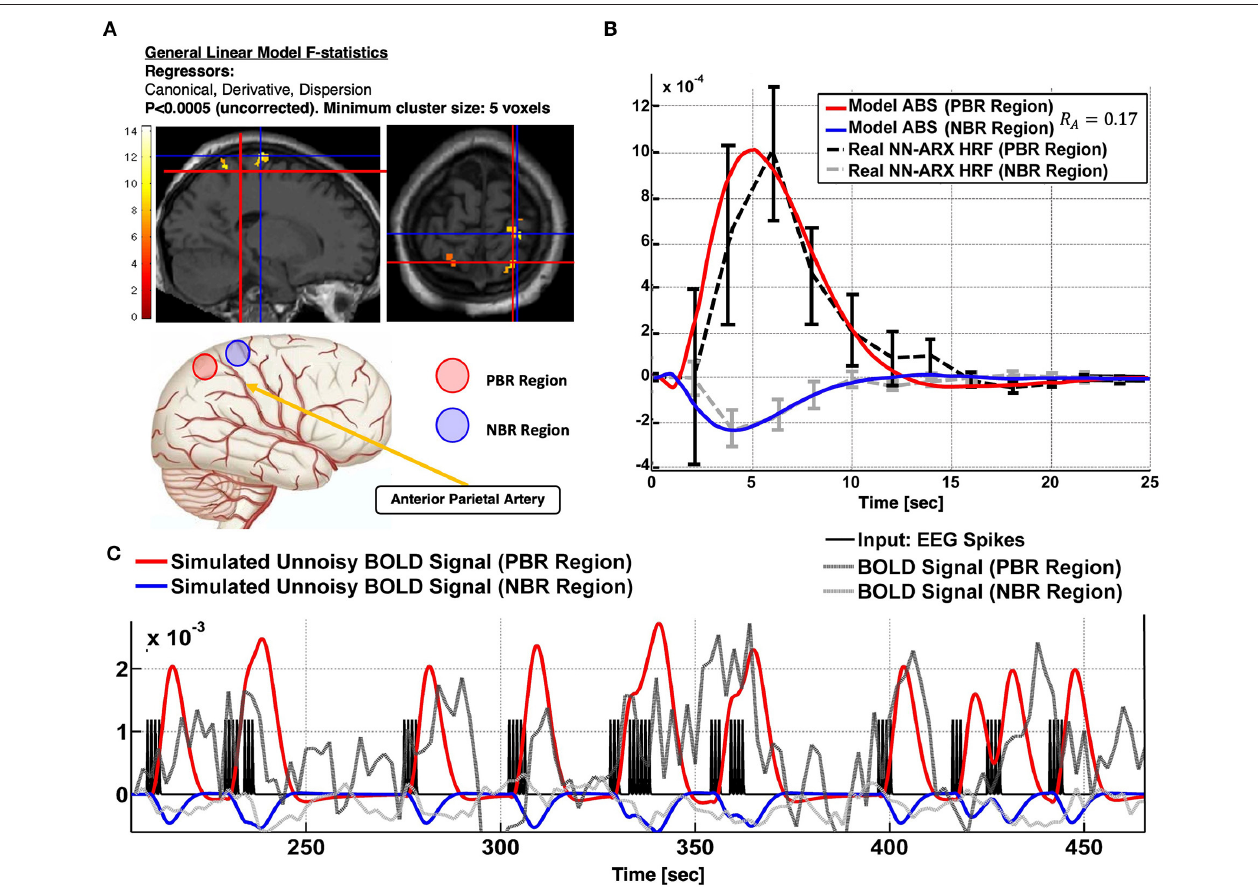
FIGURE 4 | Patient #1 shows an irritative zone with ABS-type HRF. (A) Slices showing the thresholded F-statistics map built from the estimated coefficients of the GLM overlaid on the T1-weighted image. The blue crosshair locates the center of the NBR region in the Right Post-central Gyrus; whereas the red crosshair locates the center of the PBR region in the Right Superior Parietal Lobule (SPL). The cartoon at the bottom illustrates the ABS mechanism-the regions share the final segment of the Anterior Parietal Artery. (B) The dark gray curve shows the estimated NN-ARx PBR-HRF and its confidence interval, estimated from the real data, and averaged across the voxels within a 10 mm-radius sphere with origin in red crosshair in (A) . The light gray curve shows the estimated NN-ARx NBR-HRF and its confidence interval, estimated from the real data, and averaged across the voxels within a 10 mm-radius sphere with origin in the blue crosshair in (A) . The light red and blue curves show the unnoisy simulated PBR-HRF, NBR-HRF of the fitted ABS model with the estimated values R_A = 0.17. (C) Temporal behavior of the ABS simulated BOLD in the PBR and NBR regions (with the above-mentioned estimated parameters), the time series of the real fMRI and the input used in the NN-ARx